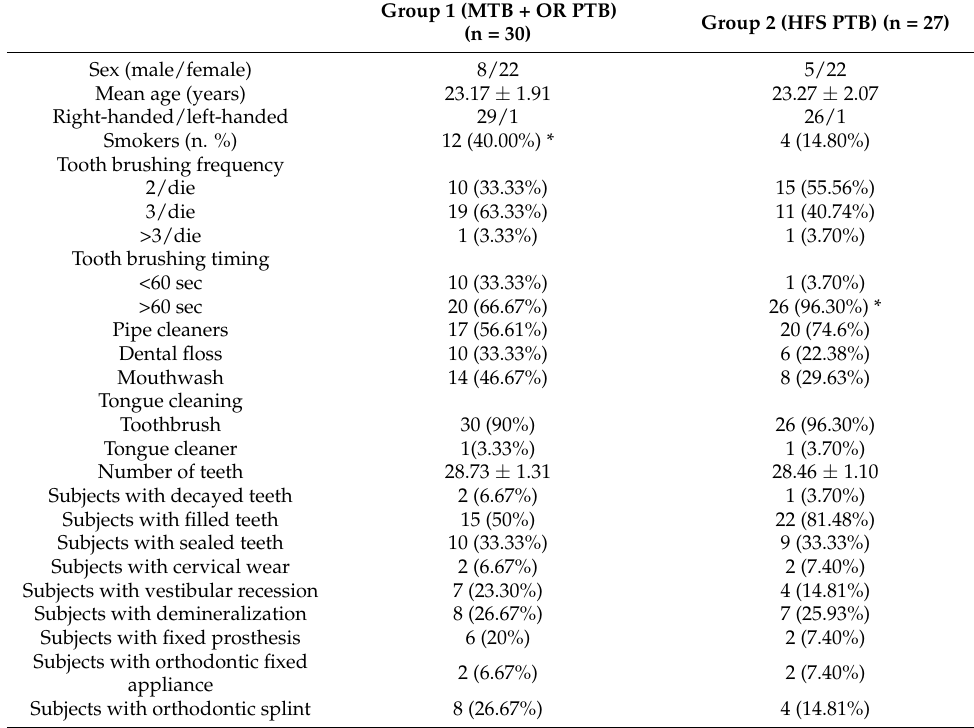
Table 1. Study population baseline characteristics (n = 57).